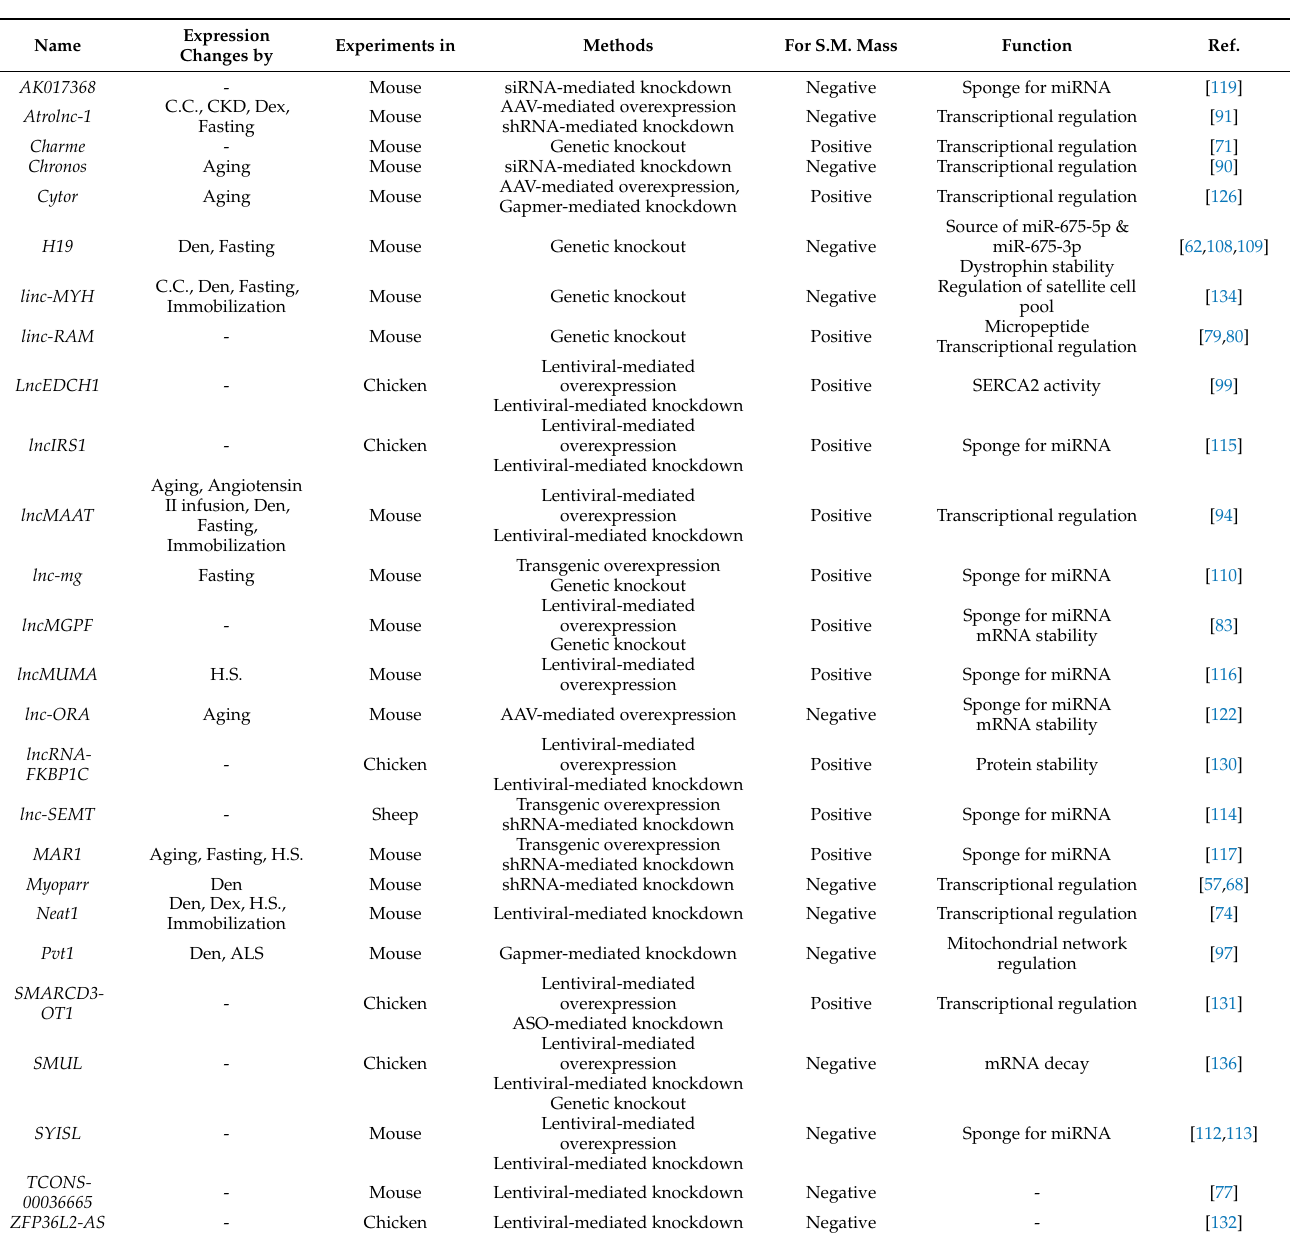
Table 1. The Summary of lncRNAs involved in the regulation of skeletal muscle mass. Data are based on the in vivo experimental results, but partially include in vitro experiments for ceRNAs. ALS, amyotrophic lateral sclerosis; C.C., cancer cachexia; CKD, chronic kidney disease; Den,